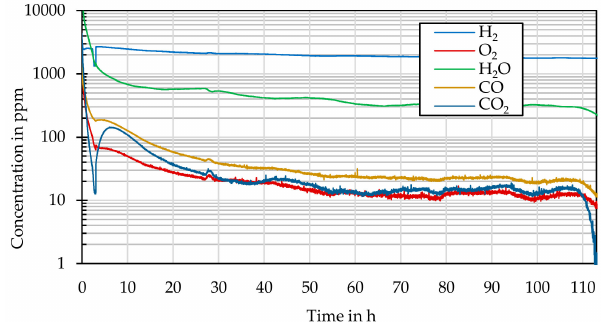
Figure 19. Representation of gaseous reaction products and impurities (H 2 , O 2 , H 2 O, CO, and CO 2 ) in the cooling gas helium during thermal annealing of Inconel